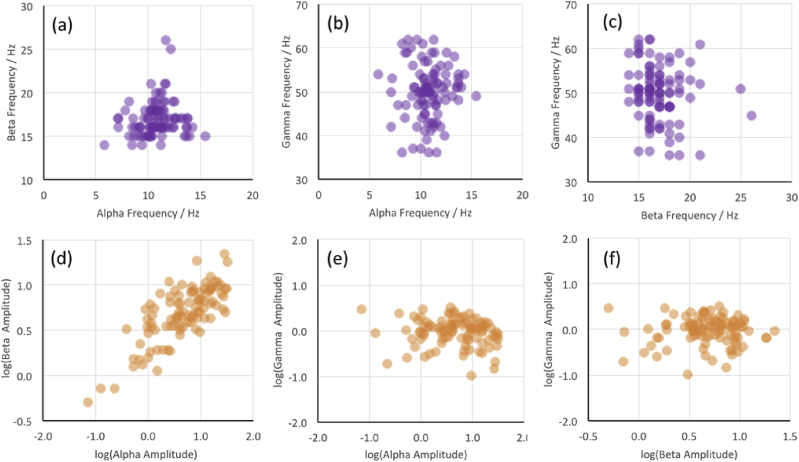
Scatter plots examining the relationships, if any, between peak frequency (top row, a–c) and peak amplitude (lower row, d–f) for the alpha, beta and gamma peaks in the stimulus response. The only apparent relationship is between the alpha and beta amplitudes, consistent with the covariance spectra shown in Fig. 3c/d.